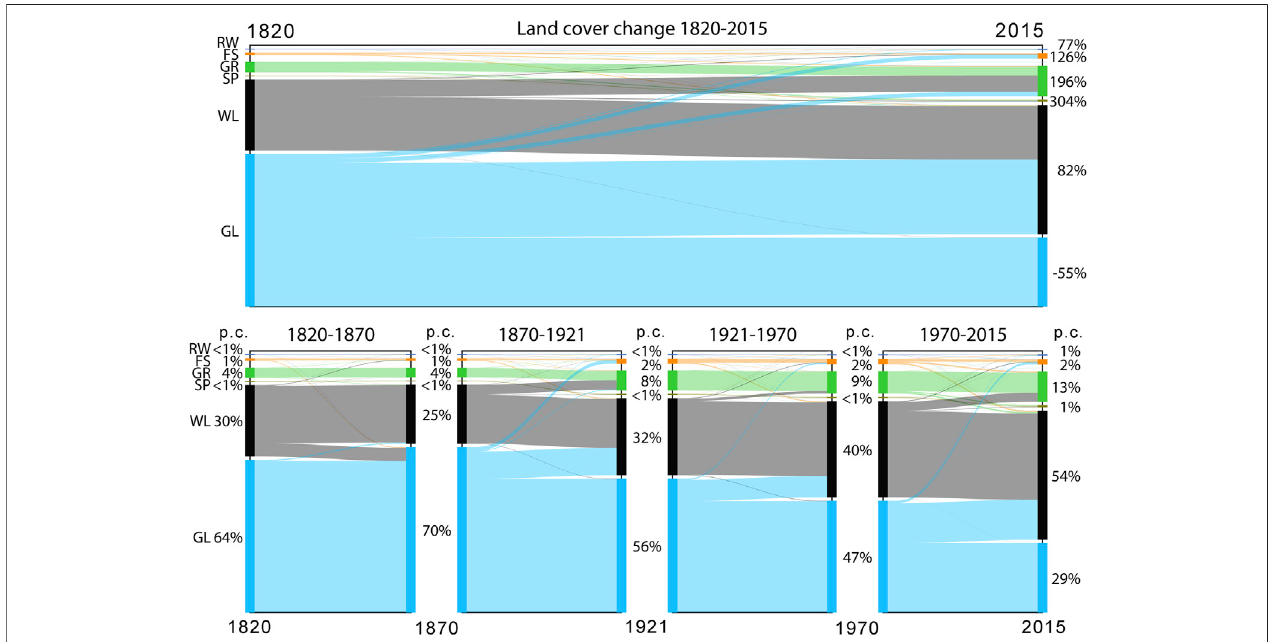
FIGURE5| LandcovertransformationintheJamtalfernersubbasinbetween1820and2015 (top) andforseparatetimeperiods (bottom) .Top:percentvalueson right margin refer to relative changes from 1820 to 2015. Bottom: percent values refer to percent cover (p.c.) of the Jamtalferner subbasin. Example bottom right: In 1970, 40% of the subbasin featured wasteland (WL, black/grey). Thereof, until 2015 a marked proportion transformed to grassland (GR, green), while large formerly glaciated areas (GL, blue) developed to wasteland (WL). Finally, in 2015, wasteland encompassed 54% of the entire subbasin. Only land cover types with a signi fi cant proportion are labelled (RW, running water; FS, fl uvial sediment; SP, sparsely wooded).